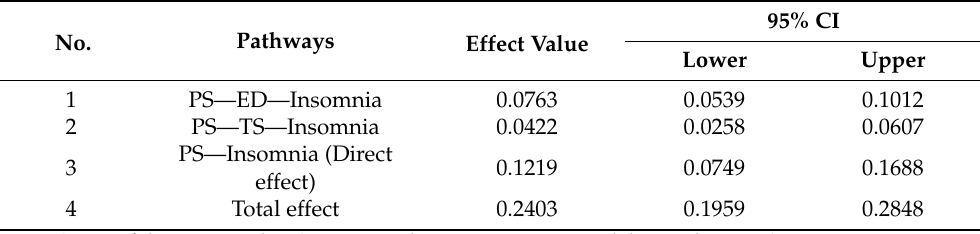
Table 3. Indirect, direct, total effects, and 95% confidence intervals for the mediation model.